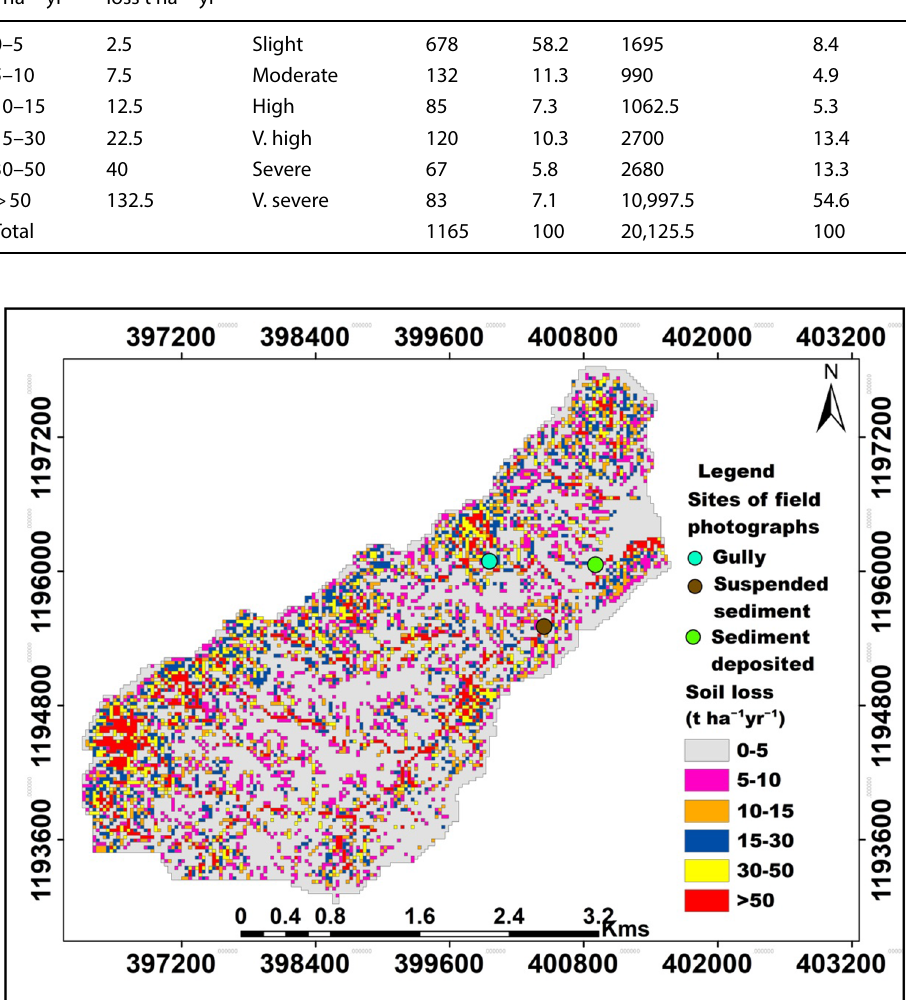
Table 7 Soil loss and erosion- risk classes of the watershed